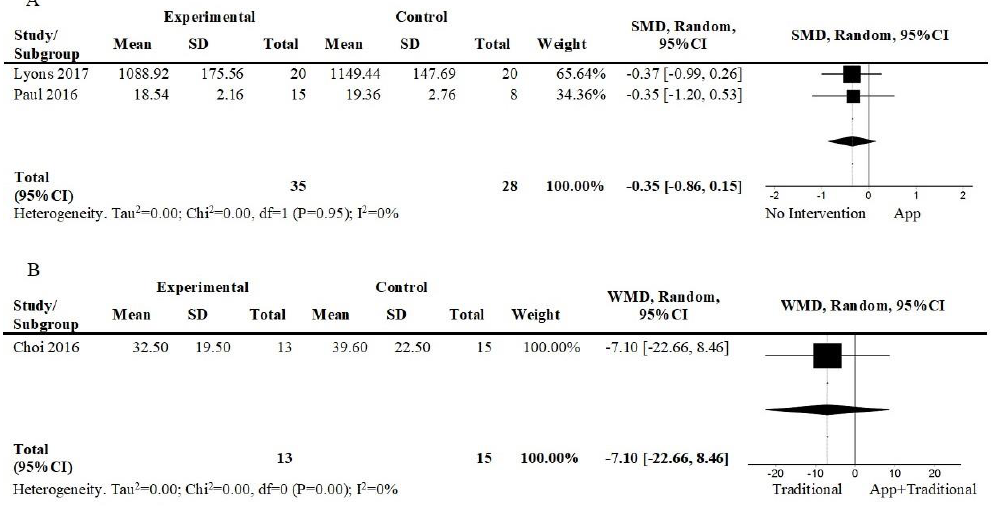
Figure 6. - Forest plot of comparison, outcome: sedentarism: A) App vs. No intervention, short term; B) App+Traditional vs. Traditional, short term. Abbreviations: CI, confidence interval; df, degrees of freedom; WMD, weighted mean difference.